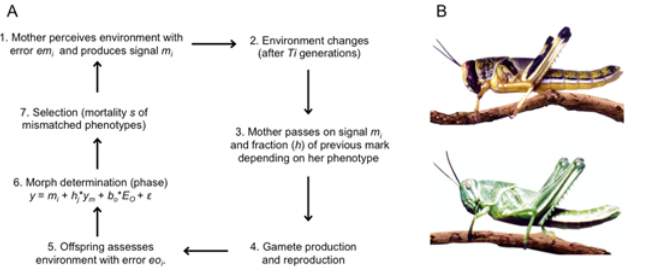
Figure 4. Locust model overview. A. Life history of locust model as explained in detail for each step, with a picture of the two phase states of the desert locust (solitary on top, gregarious on bottom); B. The non-genetic inheritance pathways relevant to this model, i.e. both a direct maternal effect depending on her environment ( m ), and a fraction of the previous generation ’ s parental mark transmitted through the germline ( h ). Image: C.